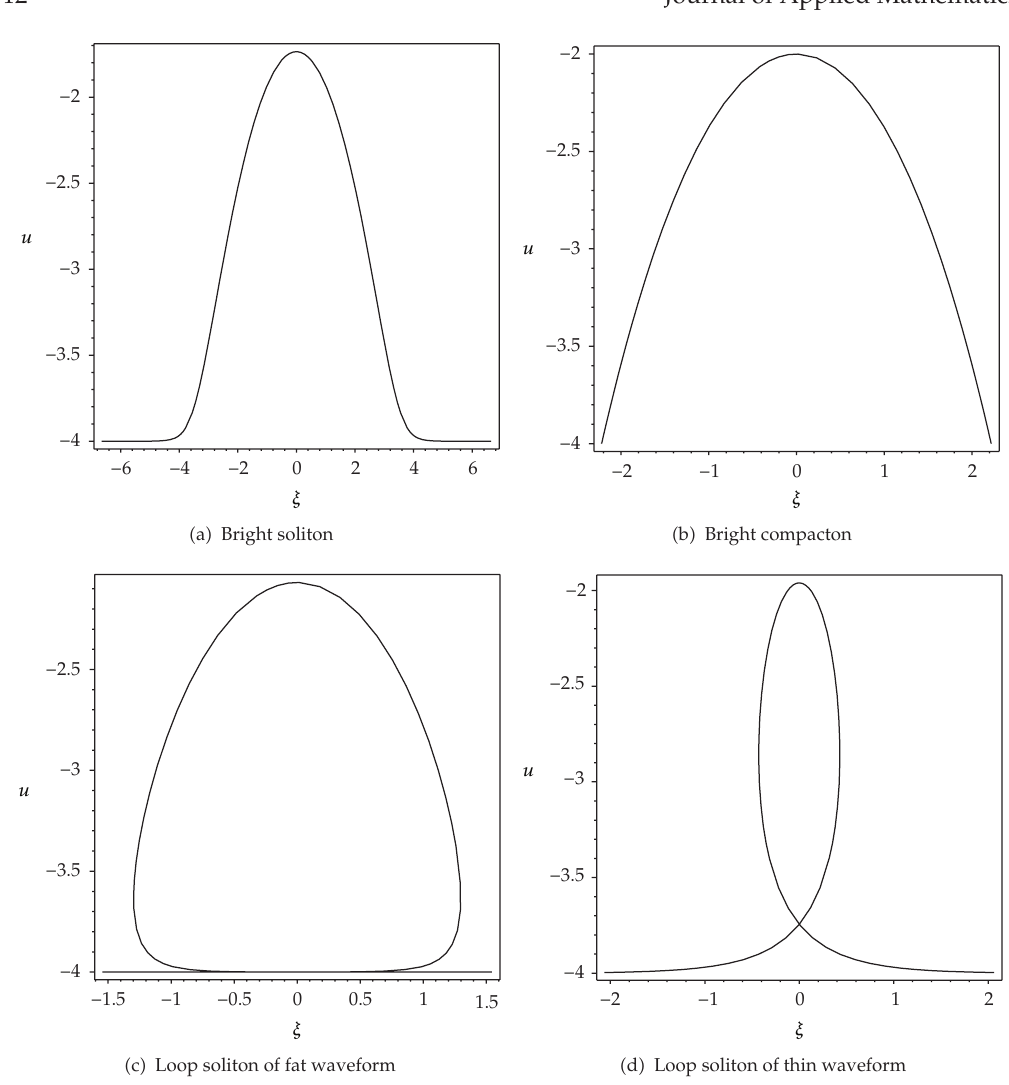
Figure 3: The profiles of multiwaveform of the first solution of (cid:2) 3.9 (cid:3) for the given parameters and di ff erent ε -values: (cid:2) a (cid:3) ε (cid:7) 1 . 8; (cid:2) b (cid:3) ε (cid:7) 2; (cid:2) c (cid:3) ε (cid:7) 2 . 2; (cid:2) d (cid:3) ε (cid:7) 2 . 8